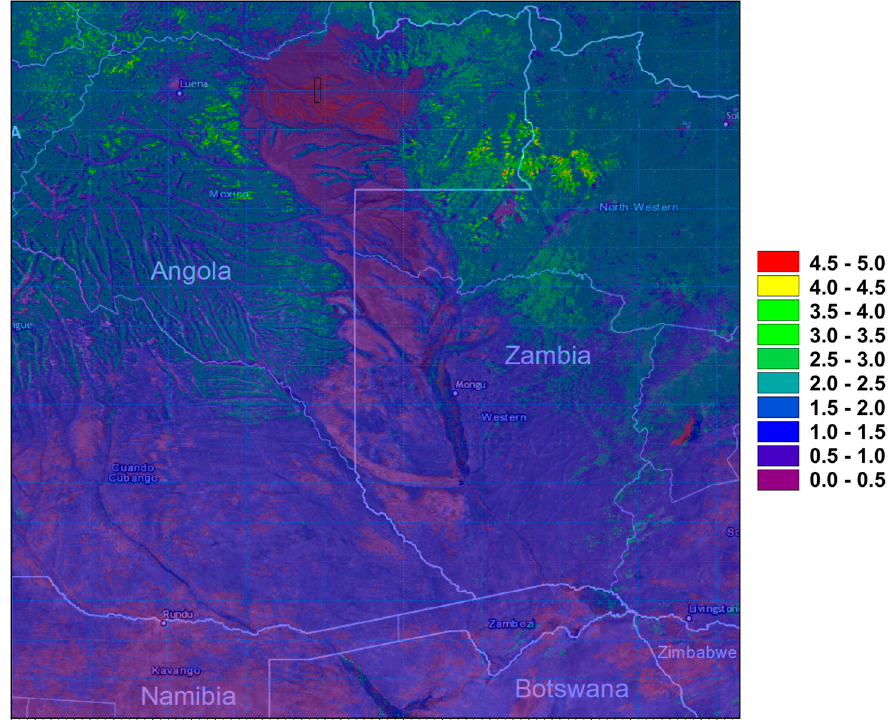
Figure 18. Screenshot of the MIKE-SHE Leaf Area Index (LAI) intensity input grid for the Upper Zambezi River Basin extracted using the Large Basin Data Portal from the MODIS datasets based on average LAI for the years 2009–2019.